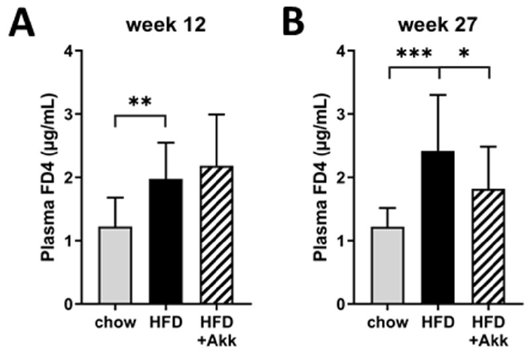
Figure 3. Heat-inactivated A. muciniphila lowers gut permeability at the end of the study. Ldlr − / − .Leiden mice were fed a chow reference diet (chow) or a NASH-inducing high-fat diet without (HFD) or with supplementation of heat-inactivated A. muciniphila (HFD + Akk) for 28 weeks. Gut permeability assessed by an in vivo functional gut permeability analysis using the Fluorescein isothiocyanate (FITC)-labeled dextran (FD4) assay in ( A ) week 12 and ( B ) week 27 of the study. Data shown are mean ± SD. * p < 0.05; ** p < 0.01; and *** p < 0.001 vs.